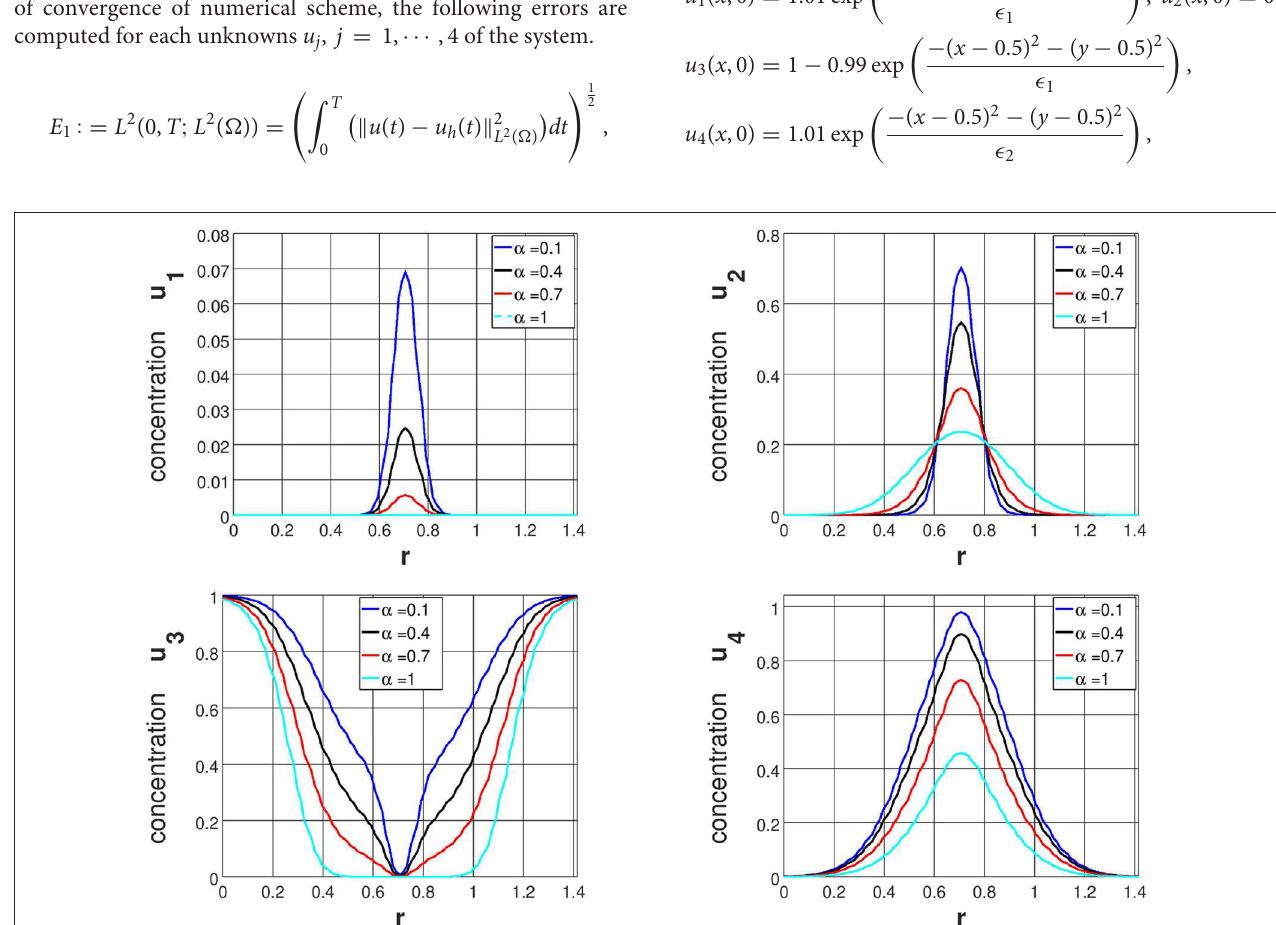
FIGURE 5 | Evaluation of u 1 , u 2 , u 3 , and u 4 at t = 15 along the line y = x .